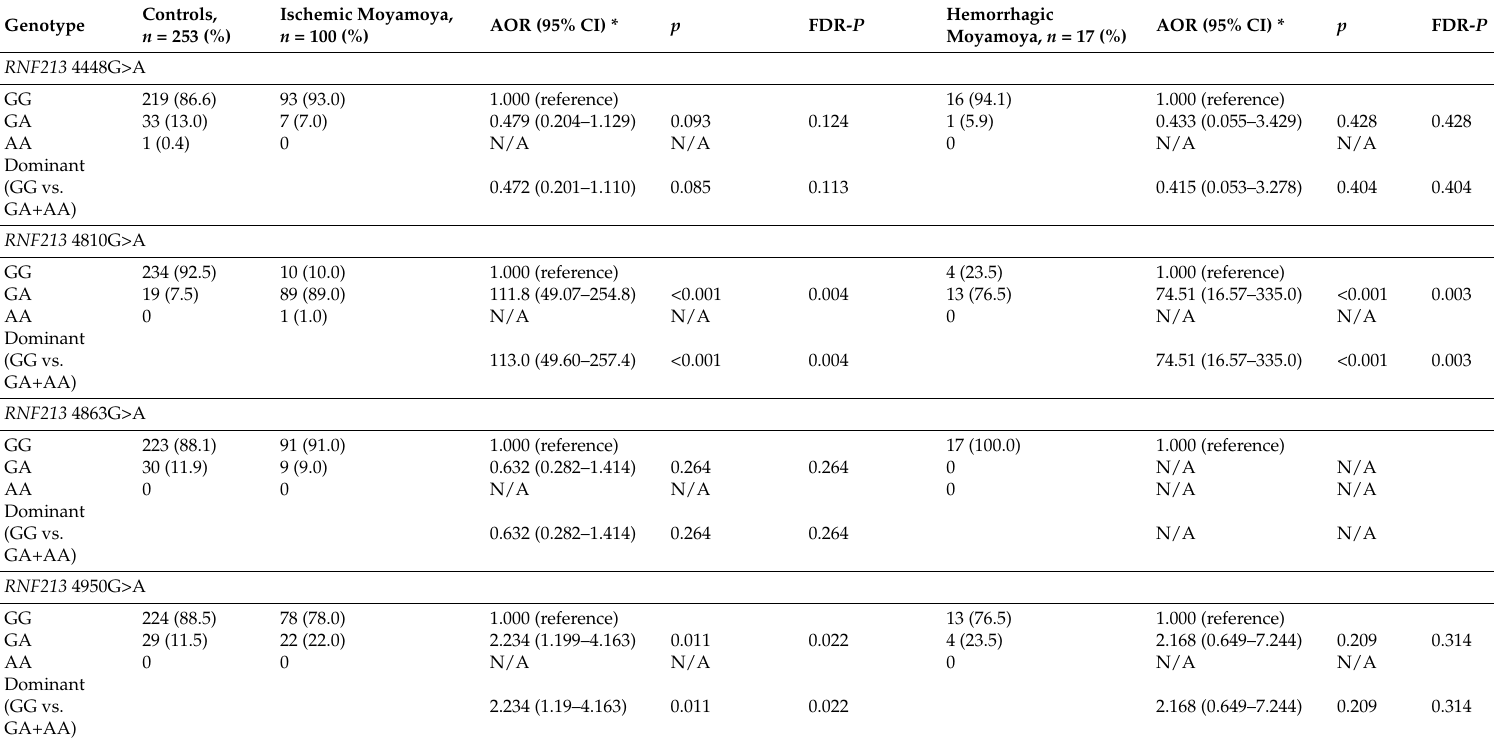
Table 3. Genotype frequencies of RNF213 in moyamoya patient subtypes and control